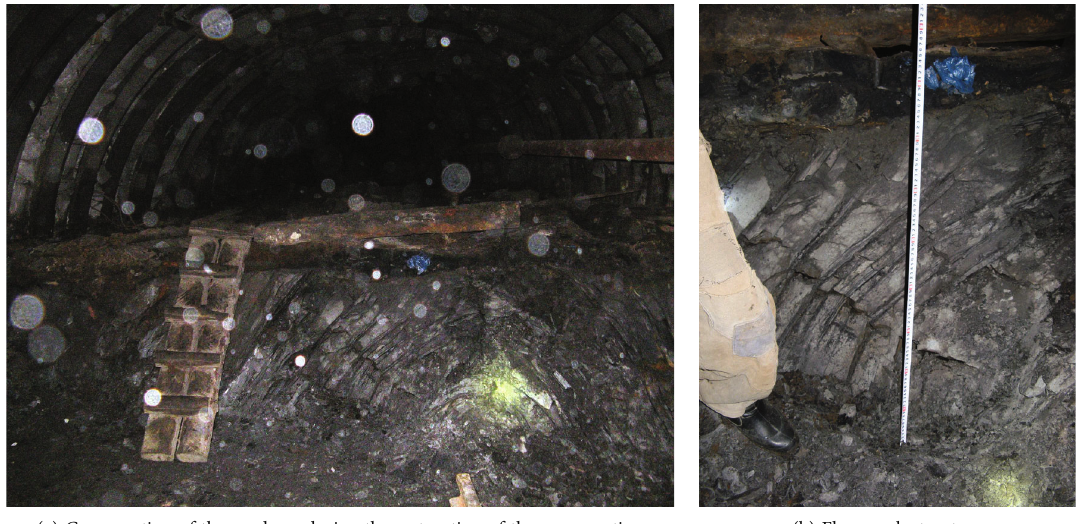
Figure 2: Excavation of rock by dramatic fl oor heave in the mine Surgaya (Ukraine) (authors ’ photo).